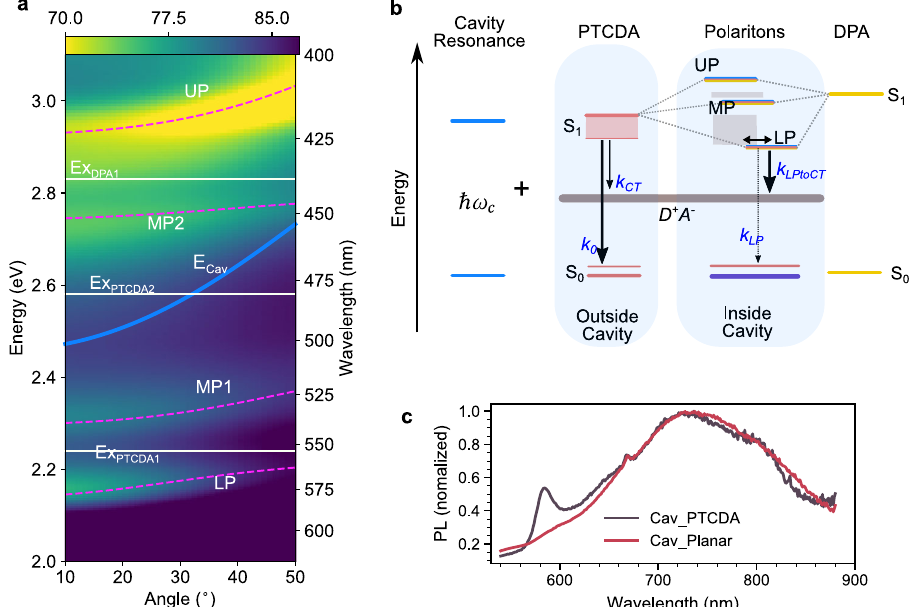
Fig. 2 Angle-resolved re fl ectivity and Jablonski diagram of the system in the strong coupling regime. a Angle-resolved re fl ectivity (transverse electric mode) of a planar HJ cavity. The white solid lines indicate the excitons (Ex PTCDA1 , Ex PTCDA2 , and Ex DPA1 ) and the blue line the cavity energy ( E Cav ). The three excitons of PTCDA and DPA are strongly coupled to the λ mode of the cavity, leading to the formation of four polaritonic modes (LP, MP1, MP2, and UP), indicated by magenta dashed lines, which are a fi t to a coupled oscillator model. b Jablonski diagram of the system. In the diagram, the two excitons of PTCDA are represented by a broad S 1 band to simplify the diagram without affecting the underlying physics. The cavity photon ( _ ω c ) couples to both PTCDA and DPA and by doing so form the upper (UP), middle (MP), and lower polaritons (LP). The gray-color bands represent dark states. k 0 and k CT are the decay rates of excited PTCDA to the ground state and charge-transfer state in the absence of a cavity, and k LP and k LPtoCT are the corresponding decay rates of LP to the ground state and charge-transfer states, respectively. The double arrow indicates the energy transfer between the exciton reservoir and LP. c Normalized emission spectra (excited at 475 nm) of the planar HJ cavity (Cav_Planar) and the reference cavity